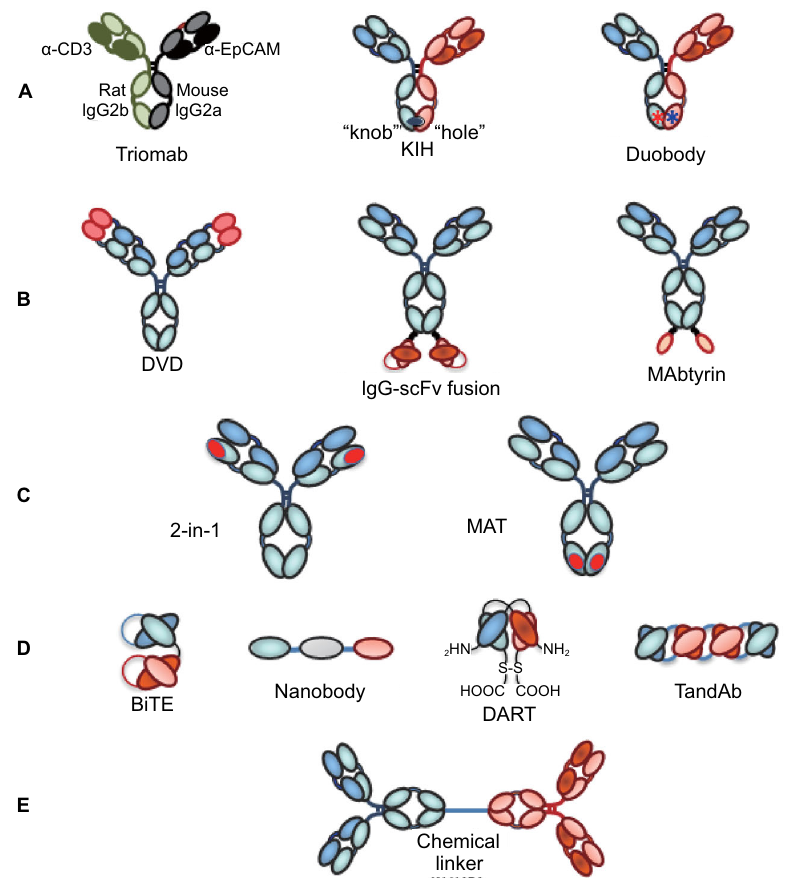
Figure 3. Five basic types of bispeci fi c antibodies. (A) Bivalent, bispeci fi c IgG-like antibodies with heteromeric heavy chains (e.g., Triomab, knobs-into-holes (KIH), Duobody, etc); (B) Tetravalent multispeci fi c antibodies comprised of IgGs with other binding domains fused to either the N- or C-termini of either the heavy or light chains (e.g., dual variable domain [DVD], IgG-scFv fusion, Mabtyrin (IgG with non-antibody binding scaffold “ centyrin ” fused to C-terminal end of heavy chains); (C) IgGs to which additional antigen combining sites have been added within the structure (e.g., two-in-one antibodies, MAT “ Modular Antibody Technology ” platform from F-Star); (D) Engineered antibody fragments linked by short peptide linkers which can be made into bivalent, trivalent, or tetravalent formats addressing two to three targets (e.g., bispeci fi c T-cell engager (BiTE), Nanobody platform, dual- af fi nity re-targeting (DART) antibodies, “ tandem antibody ” structures (TandAbs)); (E) Chemically coupled